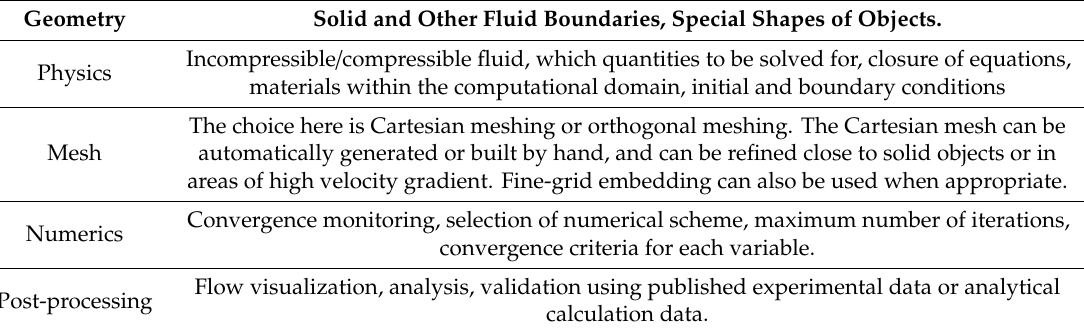
Table 1. Areas for systematic